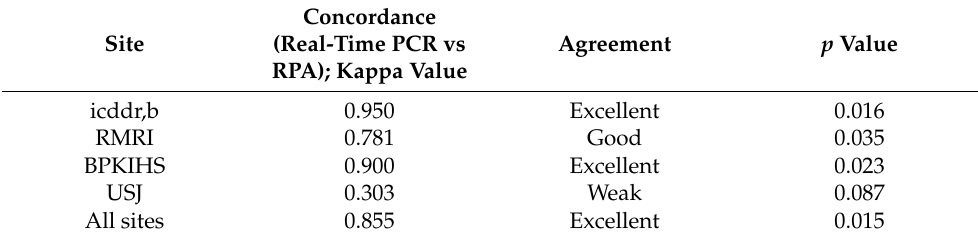
Table 4. Agreement between real-time PCR and RPA assay at different sites.